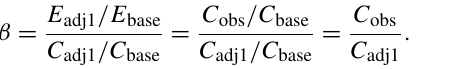
Figure 8 summarizes the characteristics of the β